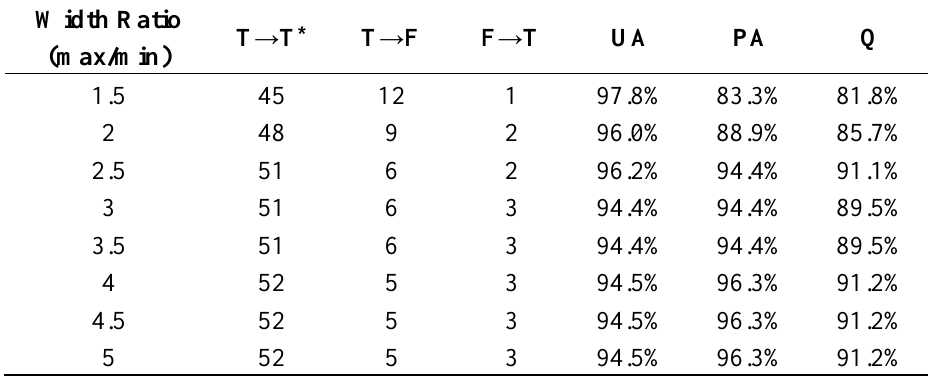
Table 5. The sensitivity of max-min width ratio (T w ) in